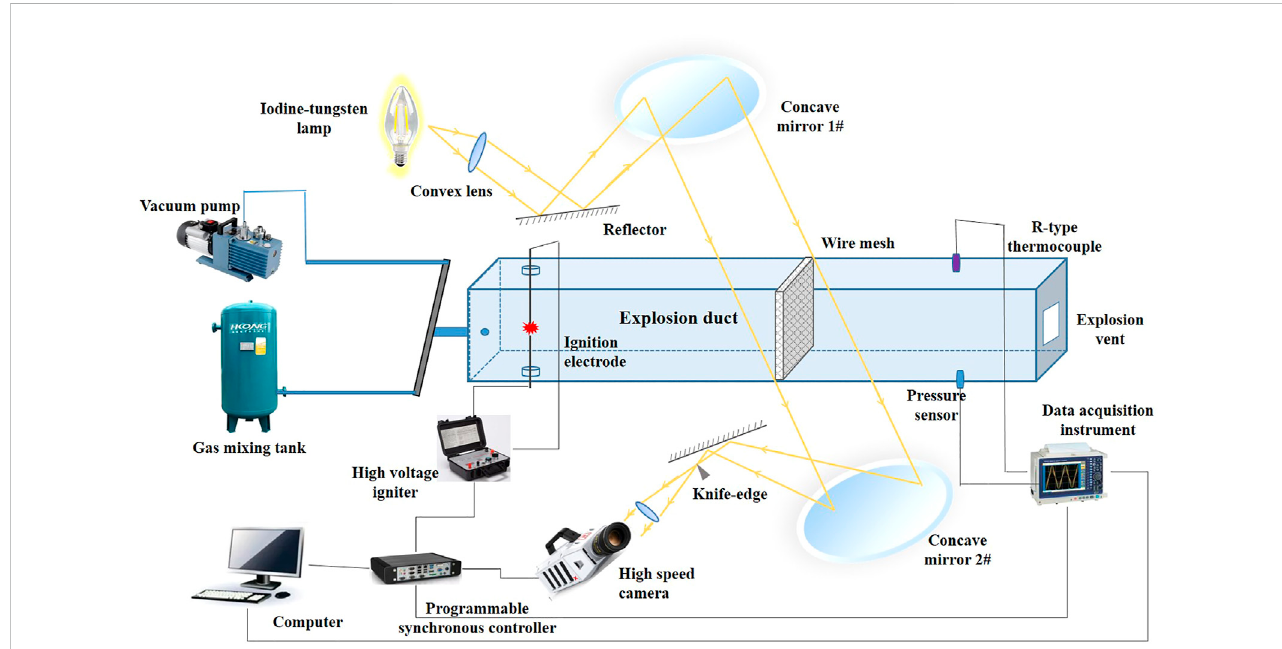
FIGURE 1 Experimental apparatus of gas explosion test system.